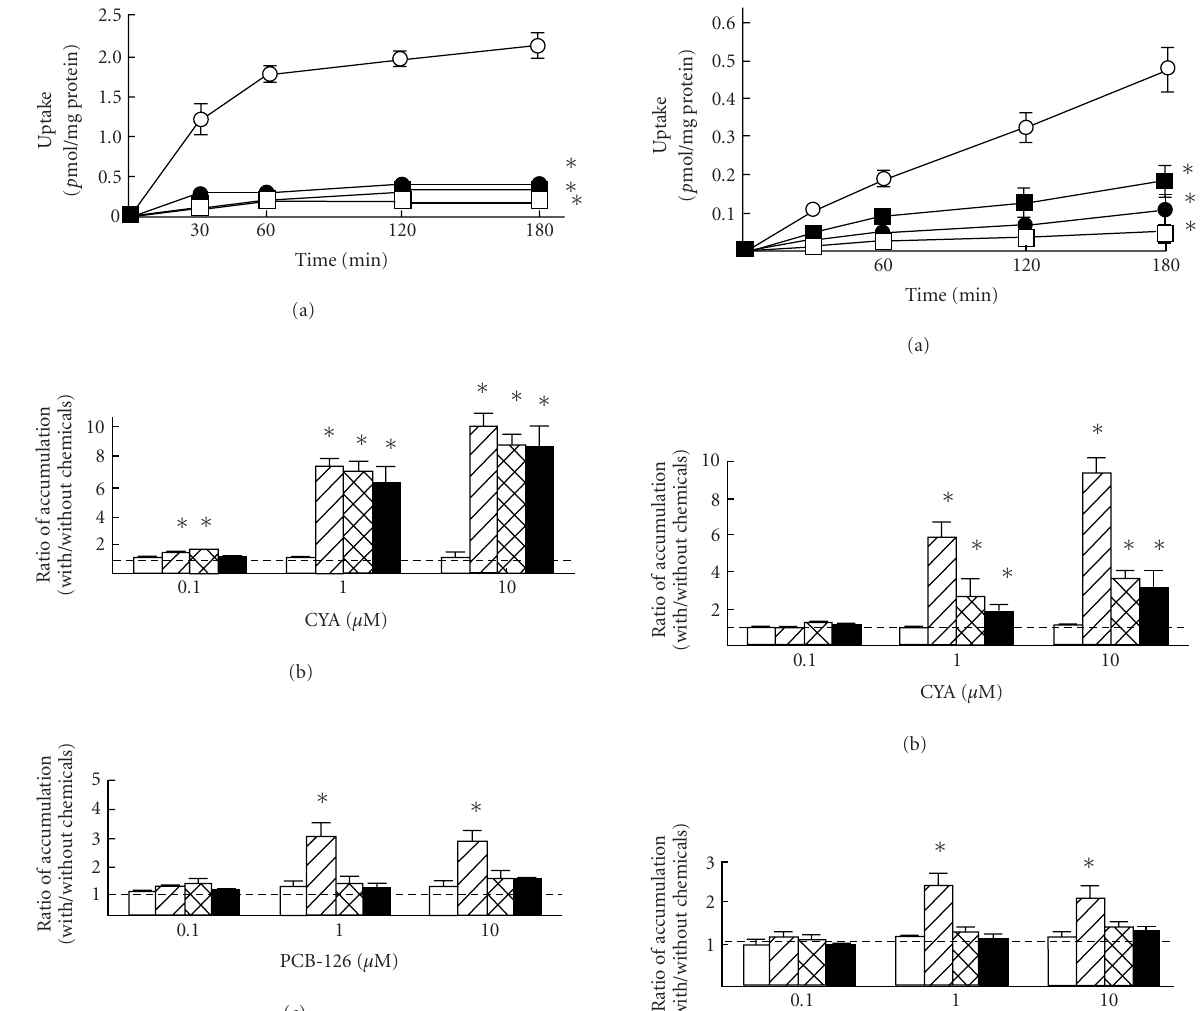
KB3-MDR1s except for KB3-Vec, and the order of drug tolerances was KB3-Ser 61 > KB3-Phe 61 > KB3-His 61 .